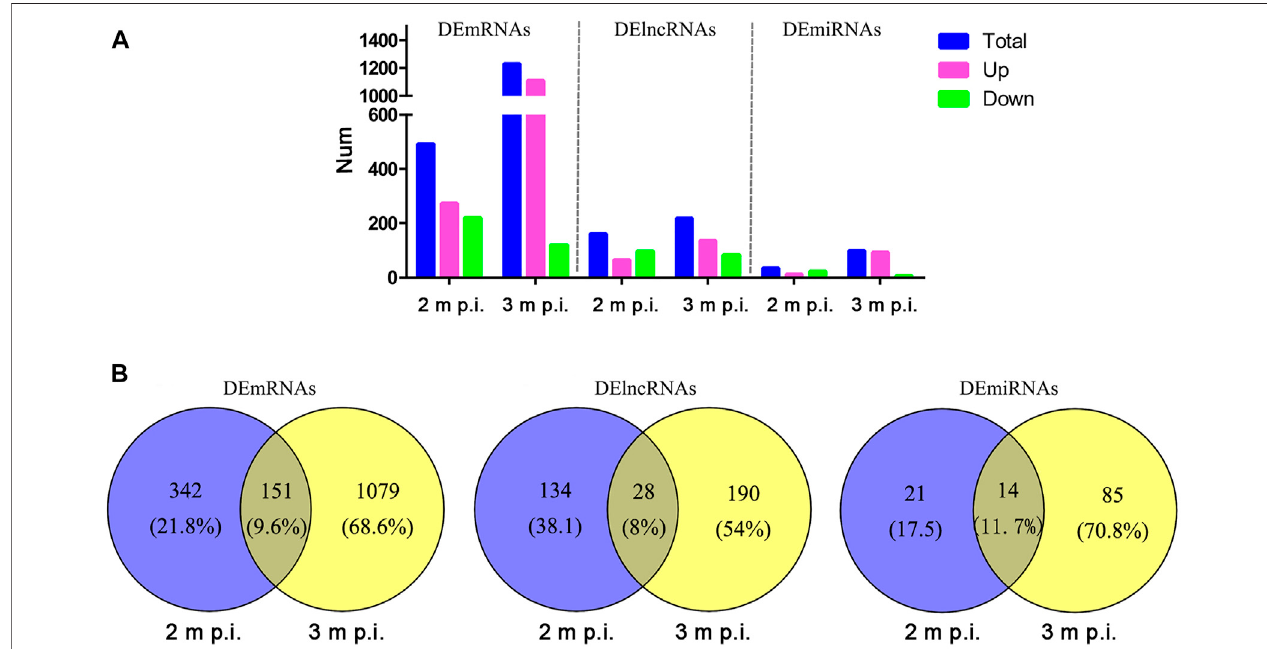
FIGURE 1 | Comparisons of DElncRNAs, DEmRNAs and DEmiRNAs differentially expressed in HCs at 2 m p.i. and 3 m p.i (A) The number of DElncRNAs, DEmRNAs and DEmiRNAsat twoinfection stages. Skyblue represents the totalnumber ofDEgemes,red and violet represents upregulated and downregulated genes, respectively. (B) Veen diagrams showing the common and unique DElncRNAs, DEmRNAs and DEmiRNAs at two infection stages.